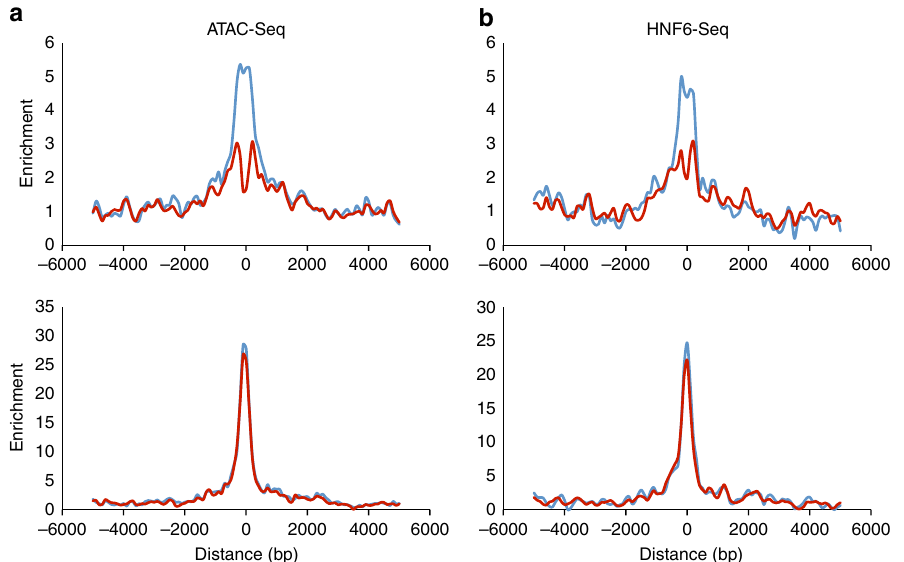
Fig. 4 Effect of DNA methylation on chromatin accessibility. a ATAC-Seq of postnatal DMRs (2800 100 bp regions as determined by RRBS) as a function of distance from their center in WT (blue) and DKO (red) adult (15 weeks) hepatocytes. Also shown for comparison (lower panel) is an analysis of hepatocyte-speci fi c prenatal DMRs that are already fully unmethylated (<5%) in 1 week hepatocytes ( n = 1290). b ChIP-Seq of postnatal and prenatal DMRs for HNF6 as a function of distance from their center tile. All curves represent the average of two independent